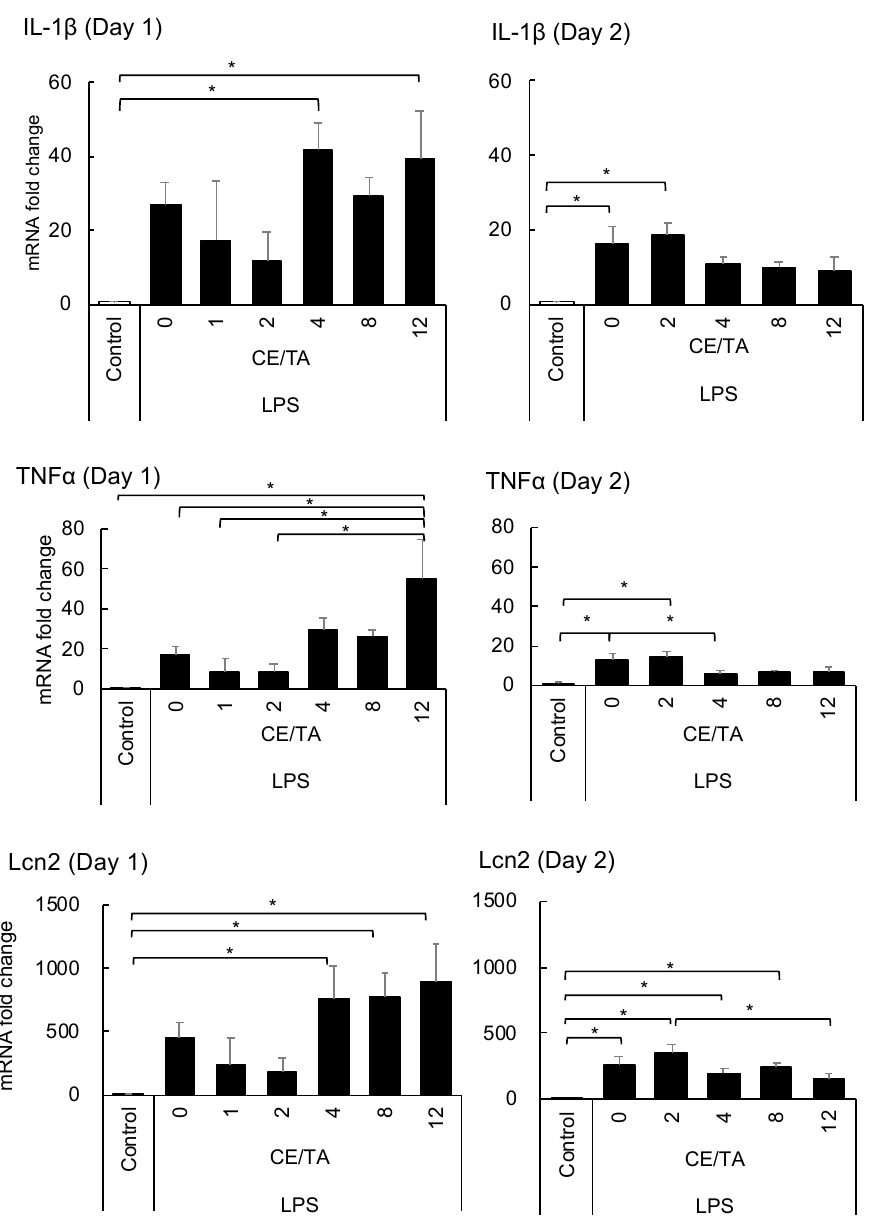
Figure 4. Effect of ingesting green tea components on inflammatory gene expression in the hippocampus of LPS-injected mice in 1-day and 2-day experiments. Mice ingested green tea components ad libitum for 6 days prior to LPS injection. Each value represents the mean ± SEM ( n = 8, * p < 0.05, Fisher’s least significant difference test).